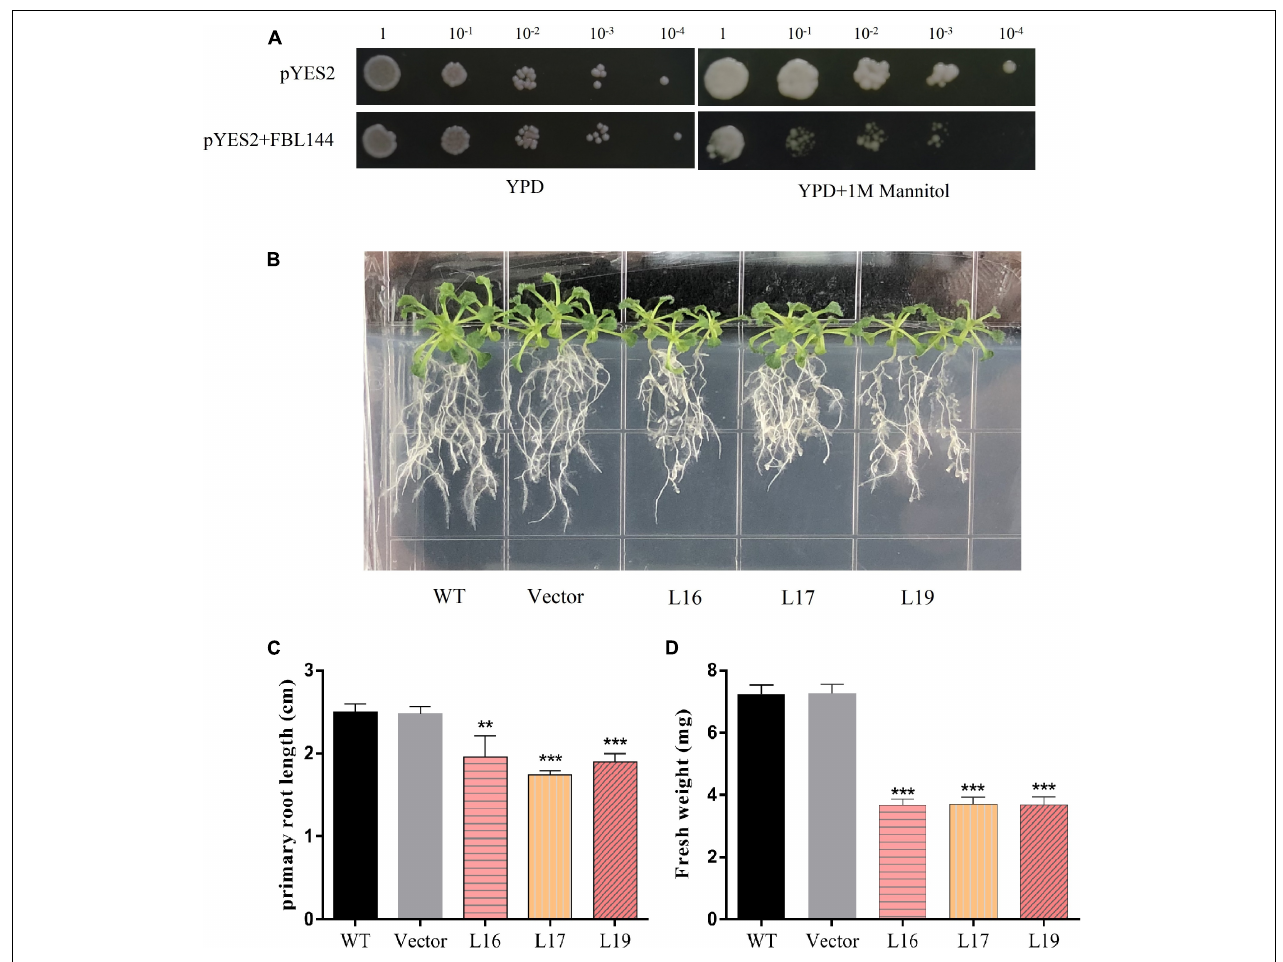
FIGURE 3 | Phenotype of transgenic Arabidopsis under simulated drought stress. (A) Phenotype of heterologous expression of GmFBL144 yeast and control under drought stress (1 M mannitol). (B) Phenotype of control (wild type and vector) and GmFBL144 -overexpression lines (L16, L17, and L19) under drought stress (250 mM mannitol). (C) Primary root length of control and GmFBL144 -overexpression lines under drought stress (250 mM mannitol). (D) Fresh weight of control and GmFBL144 -overexpression lines under drought stress (250 mM mannitol). Data represent means ± SE of three biological replicates. Asterisks indicate significant difference applying ANOVA (* P < 0.05; ** P < 0.01; *** P <